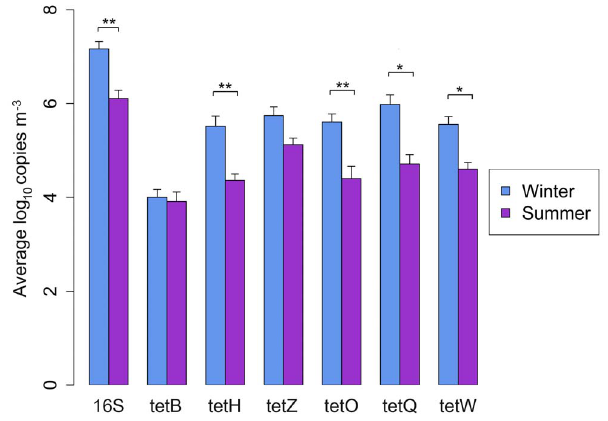
Figure 4. Abundance of 16S rRNA and tetracycline resistance genes in the bioaerosols of SCBs. Asterisks above solid lines indicate significant differences between the winter and summer seasons samples of SCBs. * indicates significantly different at . 0.05, ** indicates at . 0.01. doi:10.1371/journal.pone.0112897.g004 PLOS ONE |